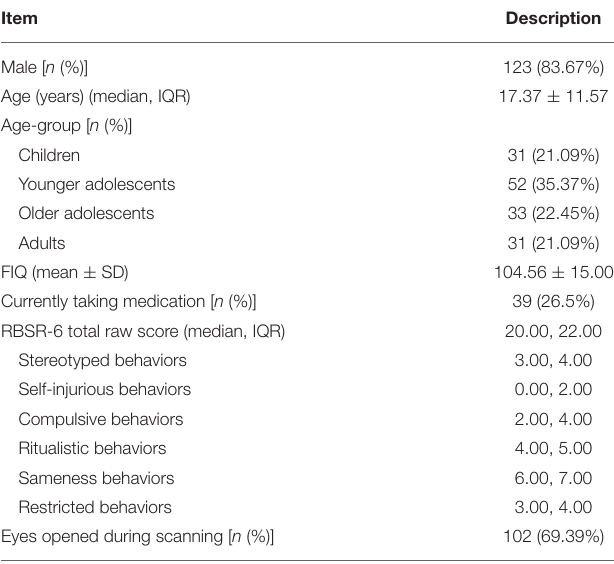
TABLE 1 | Demographic characteristics ( n =